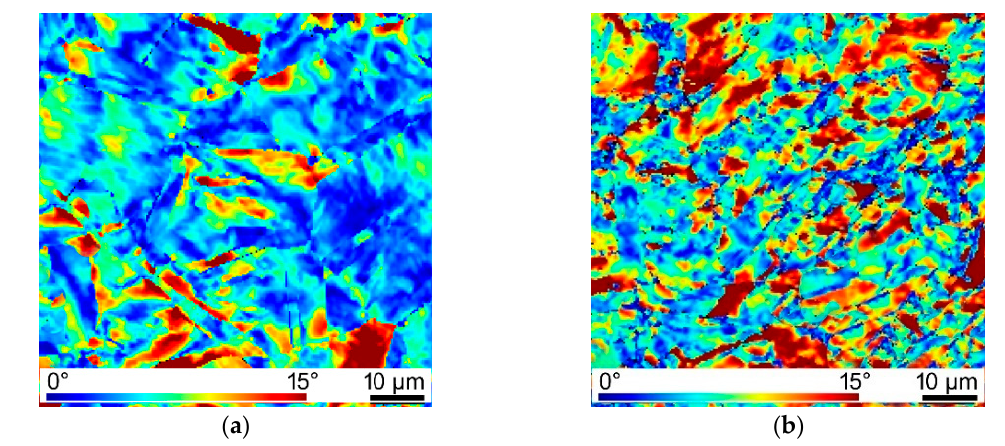
Figure 9. Maps of internal grains misorientations indicating residual stress within peripheral Cu wire of composite billet extruded via: first pass ( a ); second pass ( b ).